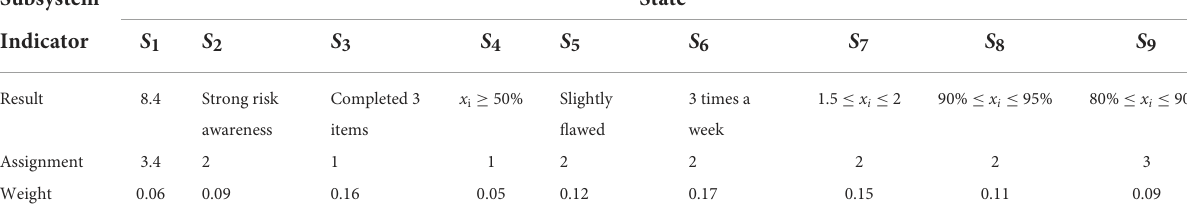
TABLE 4 Epidemic risk index collection—status system for university resumption.